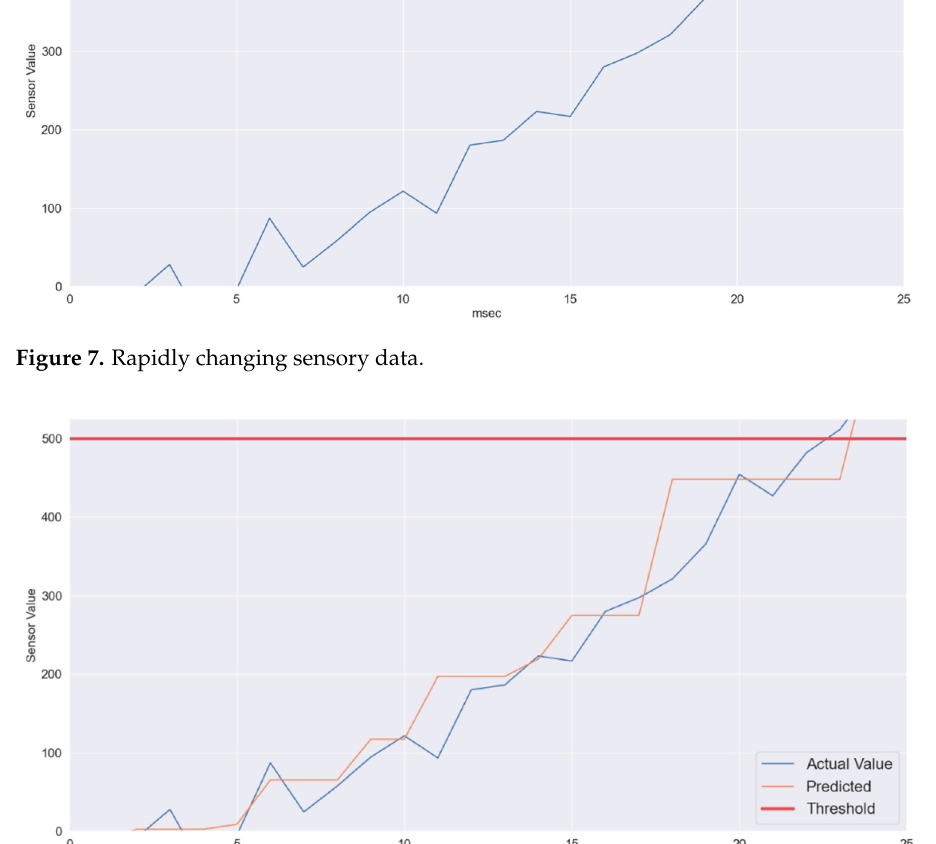
Figure 8. XGB-rapid data variations: Predicted vs. Actual.